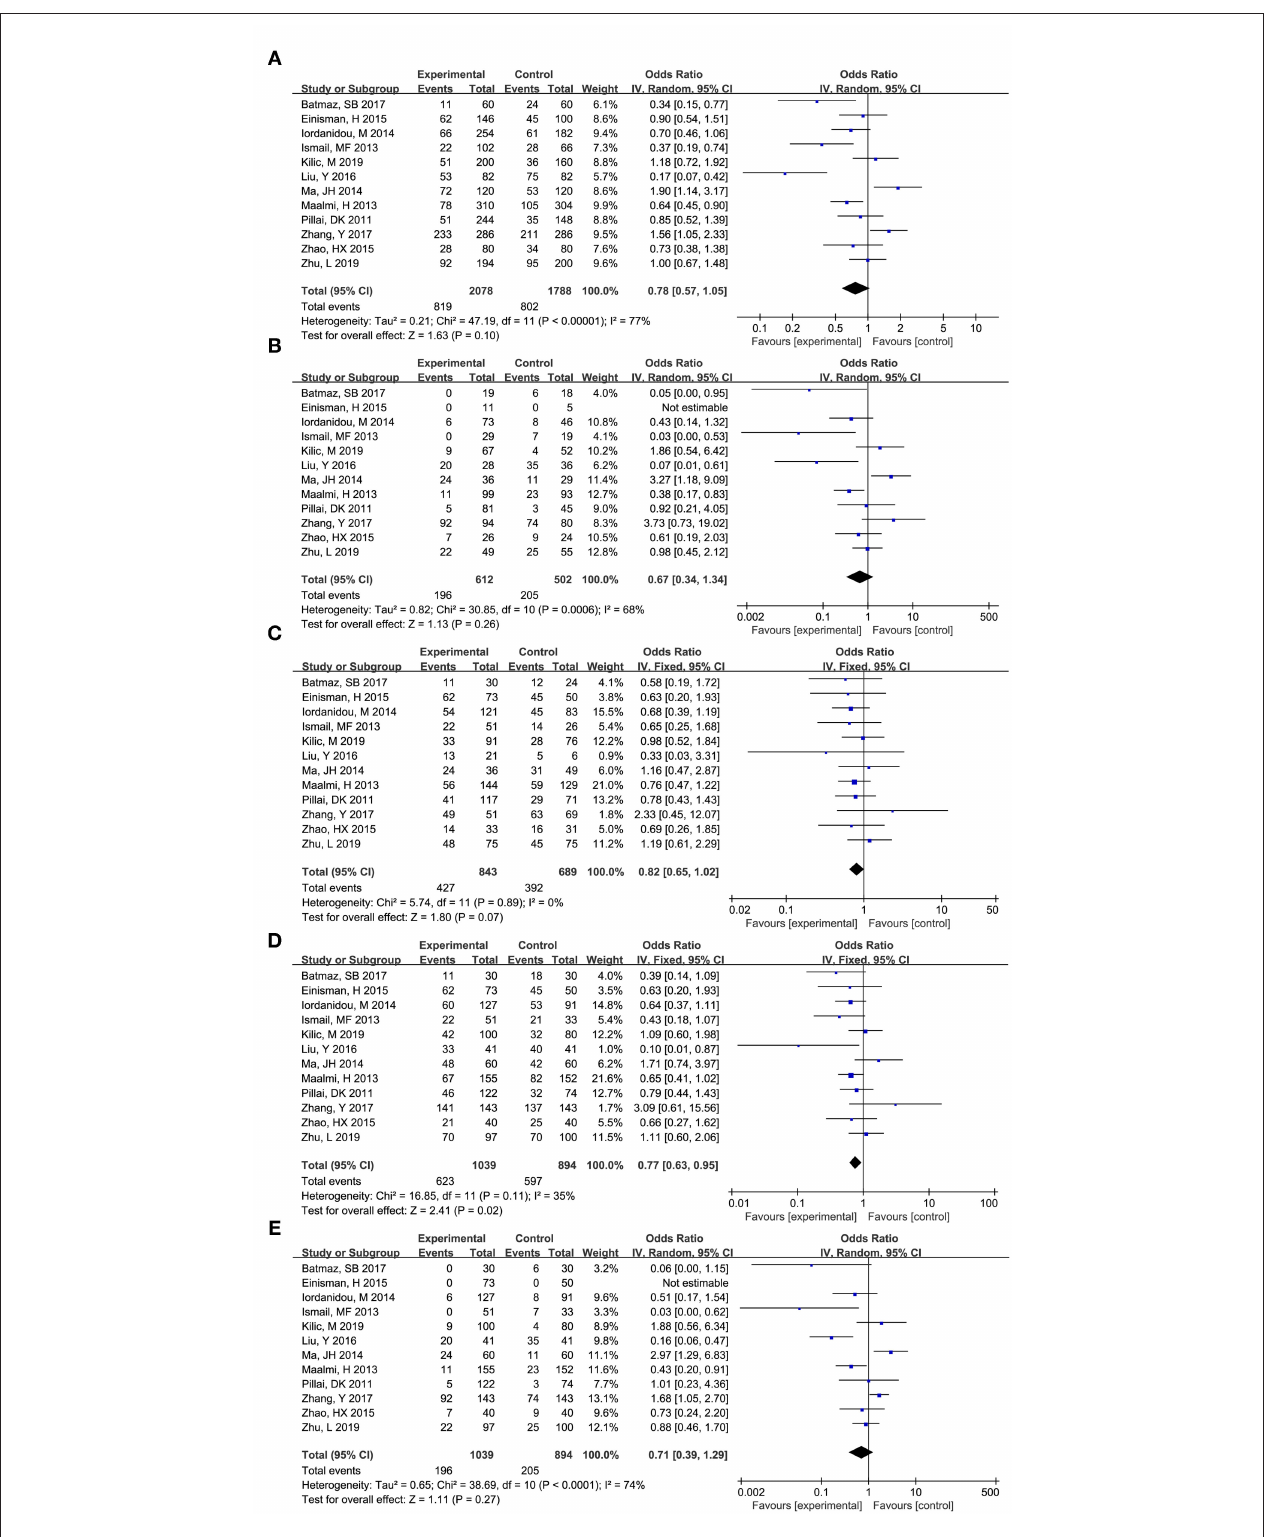
FIGURE 5 | Forest plot for meta-analyzing the association between Vitamin D receptor FokI (rs2228570) polymorphisms and childhood asthma. (A) additive model: f vs. F; (B) co dominant model: ff vs. FF; (C) co dominant model: Ff vs. FF; (D) dominant model: ff + Ff vs. FF; (E) : recessive model: ff vs. FF + Ff.